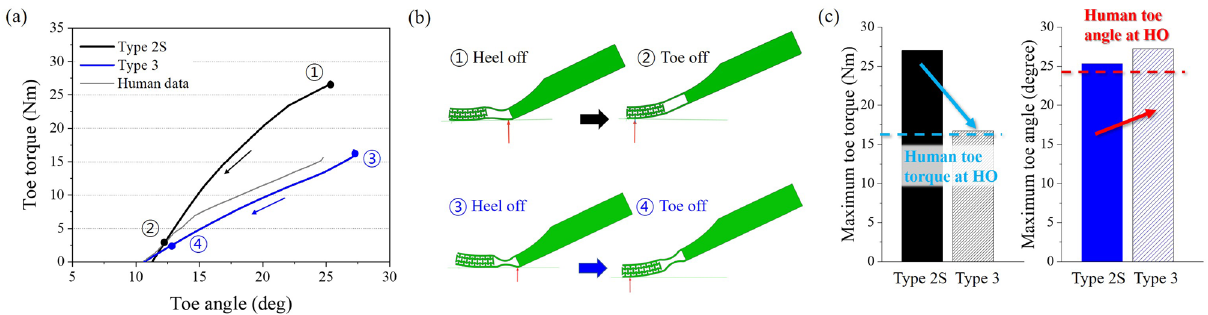
Figure 7. Simulation result of Type 2S and Type 3 models and reference human data 18 from heel off to toe